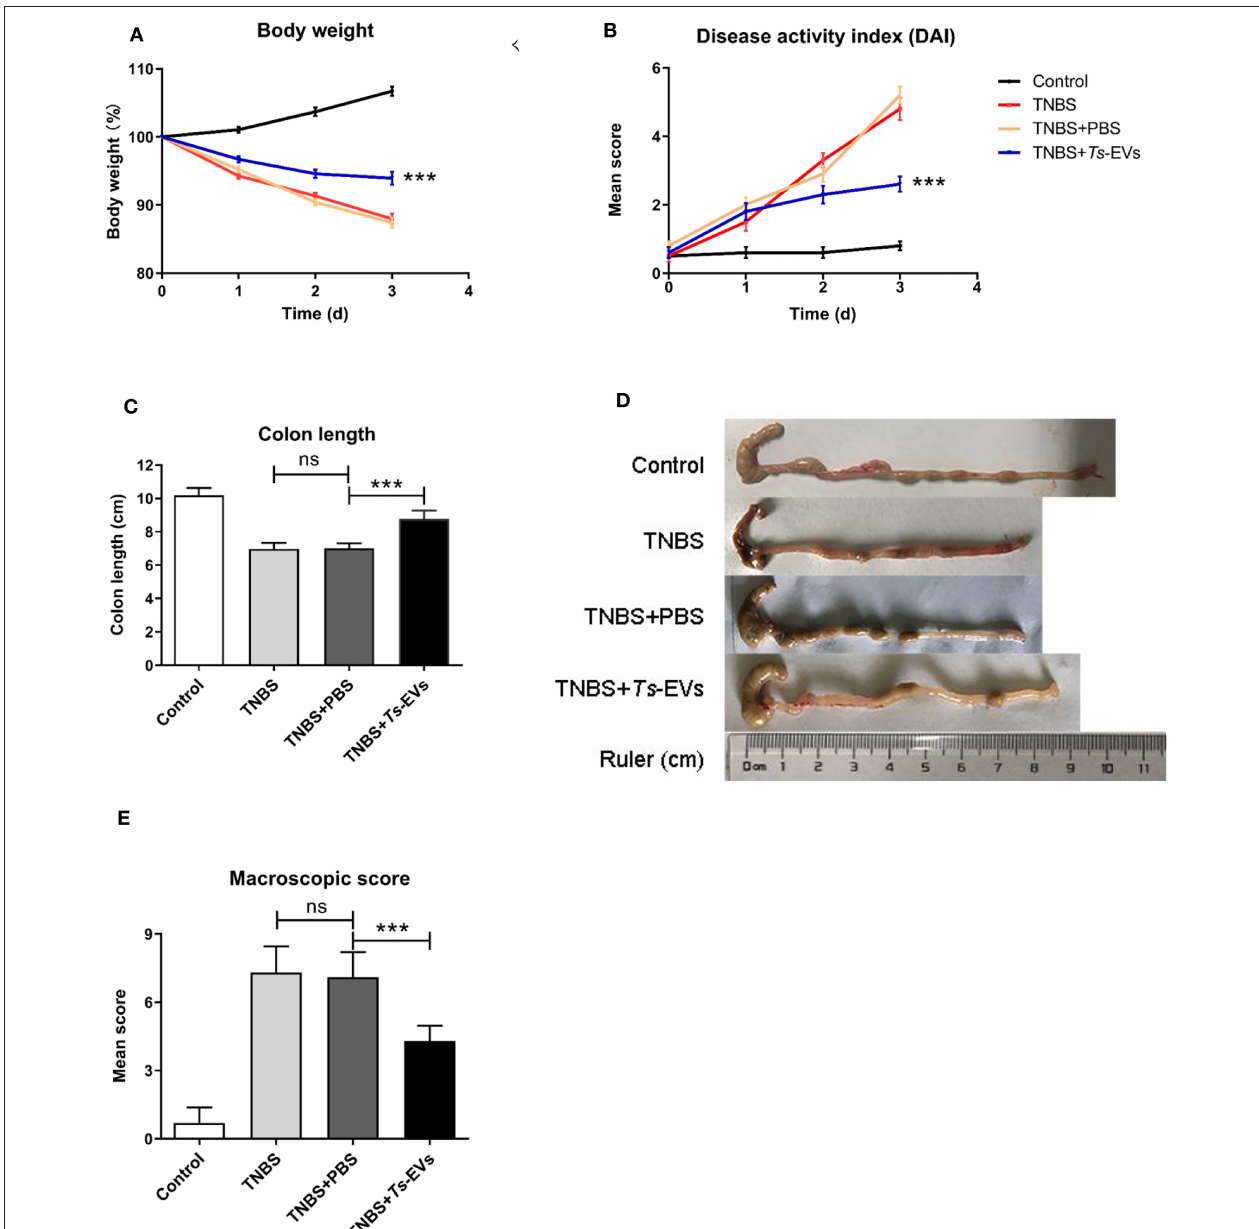
FIGURE 2 | Ts -EVs ameliorate clinical symptoms and preserve the normal macroscopic structure and length of the colon in TNBS-induced colitis. Mice received three intraperitoneal injections of Ts -EVs (50 µ g) prior to intrarectal administration of TNBS. The protective effect against TNBS-induced colitis was determined in three independent experiments. One representative experiment is shown here. (A) Body weight was recorded daily in each group. (B) The disease activity index (DAI) was evaluated daily based on three parameters (weight loss, stool shape, and presence of blood in stool), as described in methods (day 3, *** p < 0.001, TNBS + PBS vs. TNBS + Ts -EVs). (C,D) After 3 days, colons were removed and their length was measured as an indirect marker of inflammation. (E) Mean macroscopic scores of colonic inflammation based on 3 parameters (hyperemia, wall thickening, and ulcers), as described in methods. Results are shown as mean ± standard deviations (SD) of each group ( n = 10 per group). Statistical analysis was performed with one-way ANOVA followed by Tukey’s multiple-comparison test. *** p < 0.001.